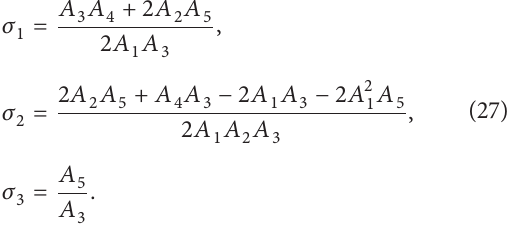
Table 2: Δ𝑆 = 𝑆(𝑡 + Δ𝑡) − 𝑆(𝑡) and Δ𝐼 = 𝐼(𝑡 + Δ𝑡) − 𝐼(𝑡)